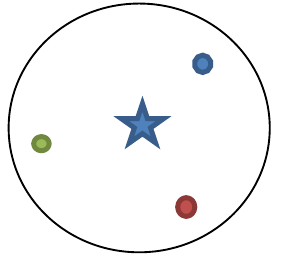
Figure 6. The produced candidate solutions around the most powerful